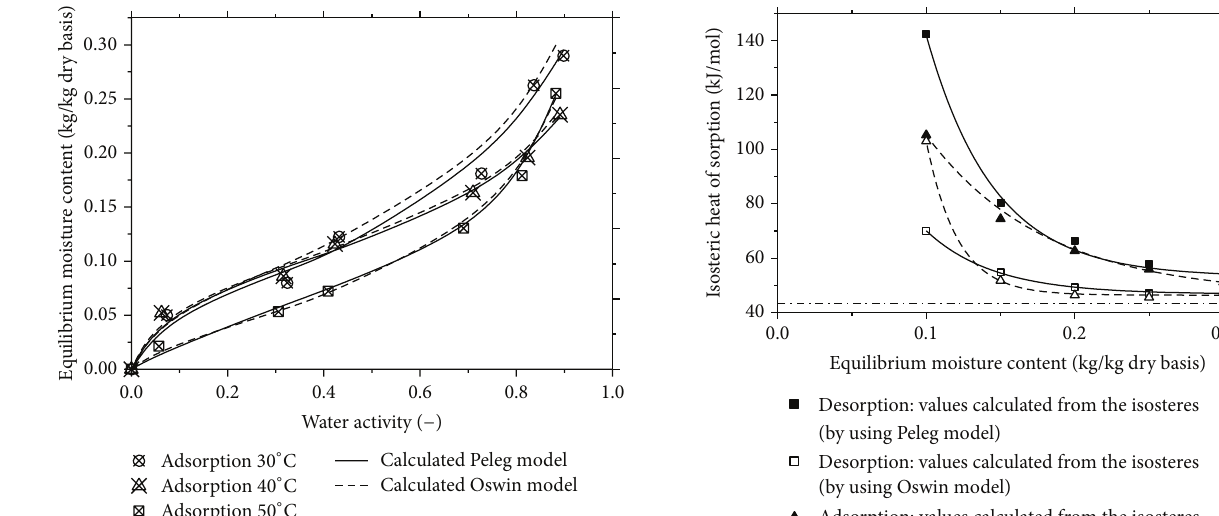
The variations of the heats of desorption and adsorption of Ziziphus spina-christi leaves with moisture content are shown in Figure 6.